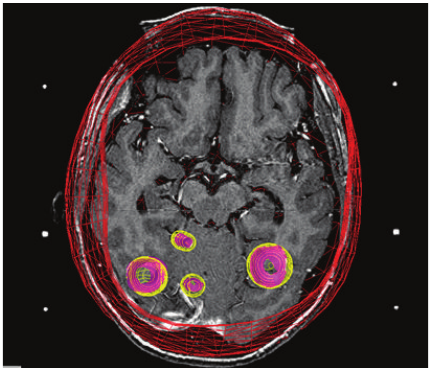
Figure 2: Axial image revealing 3-dimensional wire view of the Gamma Knife radiation dose